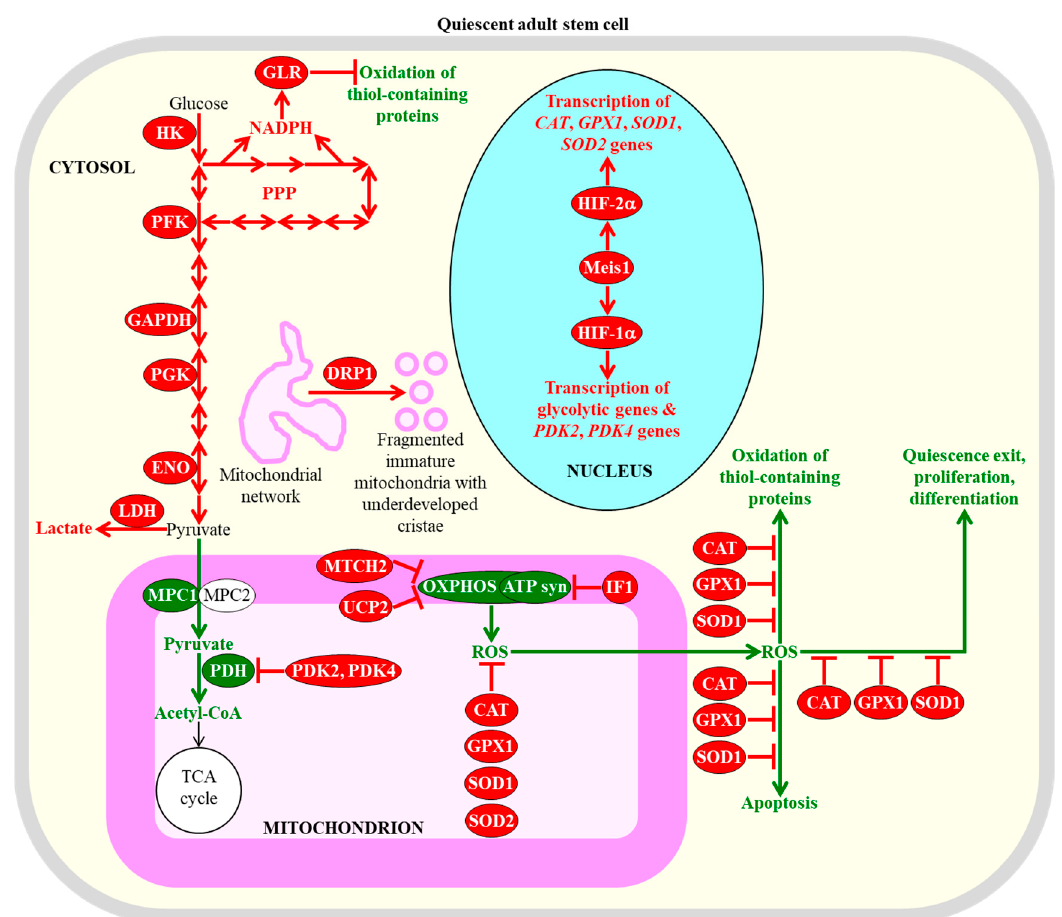
Figure 1. Some common metabolic features of adult stem cells are essential for the maintenance of their quiescence, number, proliferation potential, and differentiation ability. Among these metabolic features are carbohydrate metabolism mainly through aerobic glycolysis in the cytosol, suppressed carbohydrate oxidation in mitochondria, mitochondrial network fragmentation into globular and immature mitochondria with underdeveloped cristae, and stimulated ROS detoxification in several cellular locations. Enzymes, metabolites and processes whose activities, concentrations and rates are increased or decreased in quiescent adult stem cells (as compared to their fully differentiated progeny) are displayed in red or green color, respectively. The red one-way arrows and the red two-way arrows define irreversible and reversible (respectively) chemical reactions whose rates are increased in quiescent adult stem cells. The red inhibitory bars define inhibitory e ff ects whose intensities are increased in quiescent adult stem cells. The green arrows define chemical reactions or processes whose rates or intensities are decreased in quiescent adult stem cells. The black arrow defines the irreversible chemical reaction whose rate is not changed in quiescent adult stem cells. See text for more details. Abbreviations: ATP syn, ATP synthase; CAT, catalase; DRP1, dynamin-related protein 1; ENO, enolase; GAPDH, glyceraldehyde 3-phosphate dehydrogenase; GLR, glutathione reductase; GPX1, glutathione peroxidase type 1; HIF-1 α and HIF-2 α , transcription factor hypoxia-inducible factors 1 α and 2 α , respectively; HK, hexokinase; IF1, inhibitory factor 1; LDH, lactate dehydrogenase; Meis1, myeloid ecotropic viral insertion site 1; MPC1 and MPC2, mitochondrial pyruvate carrier subunits 1 and 2; MTCH2, mitochondrial carrier homolog 2; OXPHOS, oxidative phosphorylation; PDH, pyruvate dehydrogenase; PDK2 and PDK4, pyruvate dehydrogenase kinases 2 and 4 (respectively); PFK, phosphofructokinase; PGK, phosphoglycerate kinase; PPP, pentose phosphate pathway; ROS, reactive oxygen species; SOD1 and SOD2, superoxide dismutases 1 and 2 (respectively); UCP2, uncoupling protein 2.